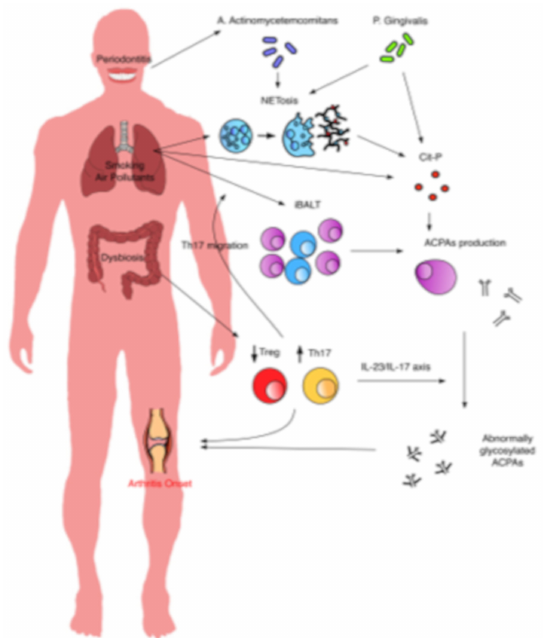
Figure 2. Interplay between mucosal events. At oral and lung levels, under the stimulus of periodontal pathogens or environmental factors, there is a production of citrullinated proteins, directly or through NETosis, and consequently ACPA production. At the gut level, dysbiosis induces the imbalance between Th17 and Treg. Th17 may migrate to the lung, contributing to iBALT formation, and at the systemic level, where, through the IL-23 / IL17-axis, the abnormal glycosylation and the acquisition of ACPA pro-inflammatory activity are triggered. Inflammatory cells and ACPAs can at last induce the onset of arthritis. Cit-p: citrullinated proteins; iBALT: inducible bronchus associated lymphatic tissue; IL-: